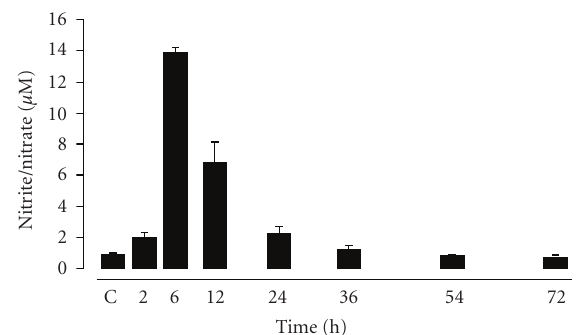
Figure 2: Time course of nitrite/nitrate levels. The nitrite/nitrate assay was performed in rat pleural exudates collected from control rats (C) or Cg-treated rats at 2, 6, 12, 24, 36, 54, and 72 hours after pleural injection. The values are expressed as mean ± S.E.M. of 6 to 8 rats.